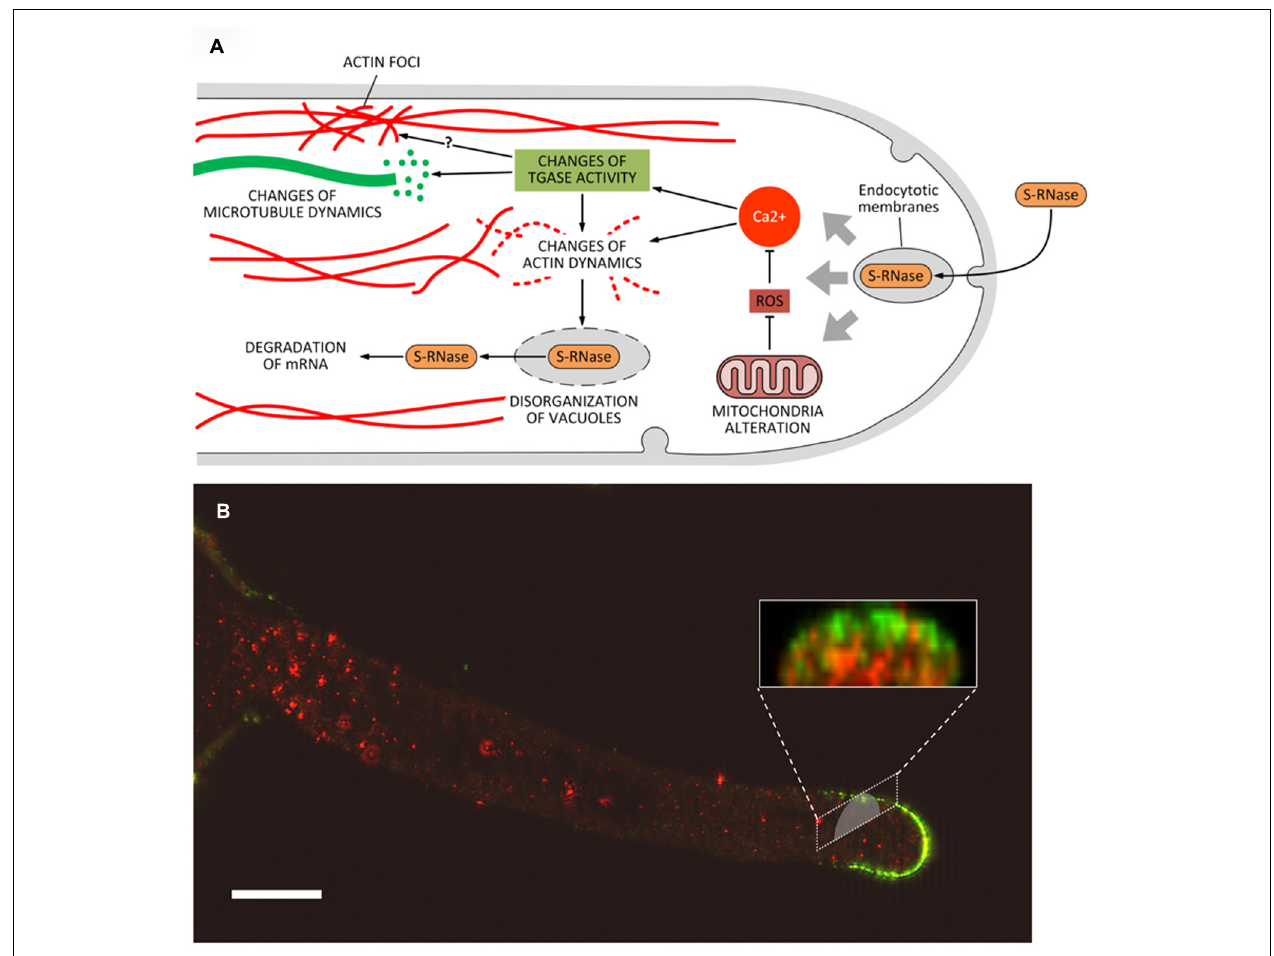
FIGURE 5 | (A) Model of the potential role of transglutaminase (and PAs) during the process of self-incompatibility in pear. S-RNase would be incorporated by endocytosis.This process would trigger a series of subsequent events, including the alteration of mitochondria morphology and consequently the production of ROS. In turn, abnormal levels of ROS might modify the intracellular concentration of Ca 2 + thus leading to substantial modifications in the structure of actin filaments and/or to interference in the activation/regulation ofTGase. As a result, further changes at level of actin (formation of actin foci) and microtubules may also occur. Along with the degradation of mRNA caused by S-RNase released in the cytoplasm, these